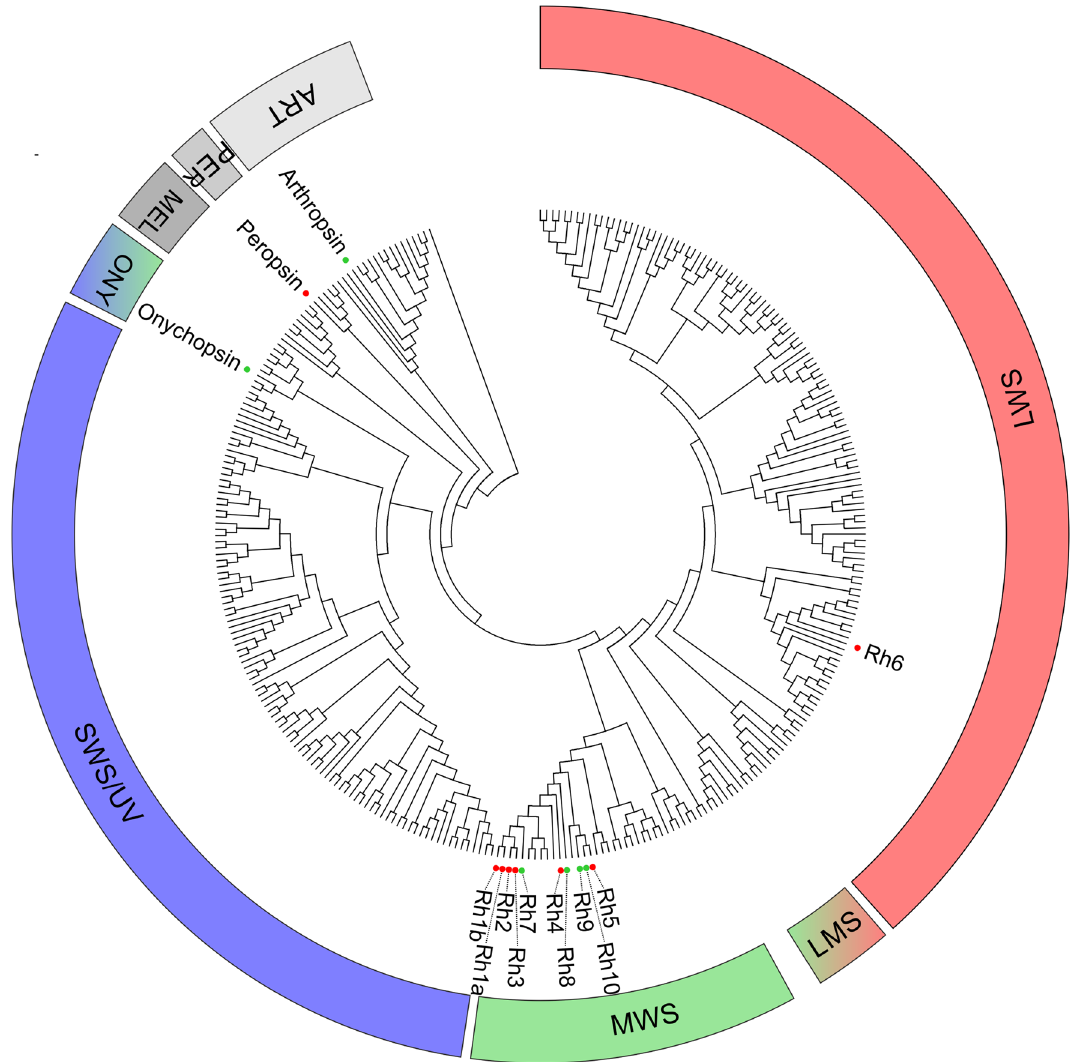
Figure 2. Phylogenetic relationships of Euphausia superba opsins shown as circular cladogram. Colored dots indicate krill opsins: red, previously cloned opsins; green, novel identified opsins. The spectral sensitivities of rhabdomeric opsin clades were inferred from the curated invertebrate-only opsin dataset proposed by DeLeo & Bracken ‐ Grissom, 2020. Represented opsin classes: LWS, long-wavelenght-sensitive; LSM, long/middle- wavelenght-sensitive; MWS, middle-wavelenght-sensitive; SWS/UV, short/UV-wavelenght-sensitive; ONY, onychopsins; MEL, melanopsins; PER, peropsin; ART, arthropsin. Rectangular phylogram is reported in Fig. S1 (Supplementary